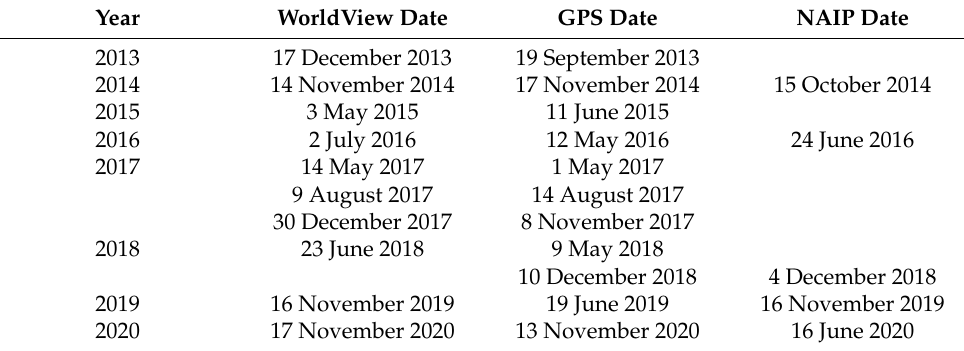
Table 2. The dates of collection for WorldView satellite imagery, Real-time Kinematic Global Posi- tioning System (GPS) field-surveys, and aerial imagery shoreline (AIS) data. The remote sensing data were paired by year with the closest available GPS field survey